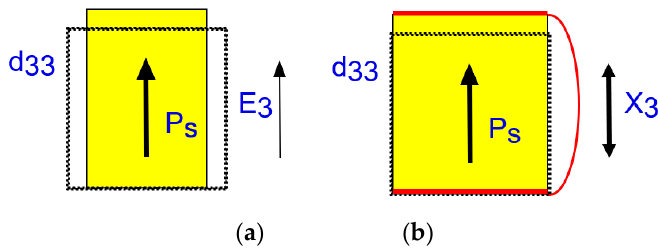
Figure 4. Calculation models of electro-mechanical coupling factor k for ( a ) electric input under stress free, and ( b ) stress input under short-circuit condition.